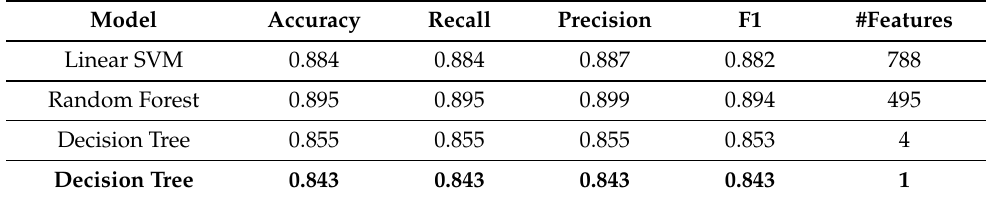
Table 5. Classification results image focus assessment.